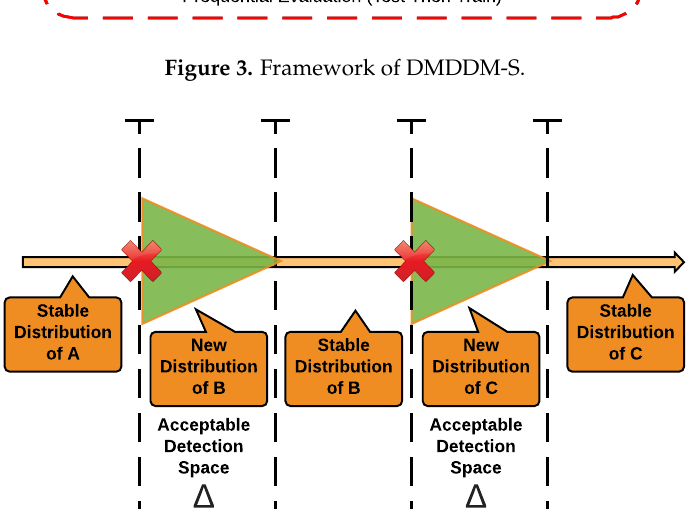
Figure 3. Framework of DMDDM-S.